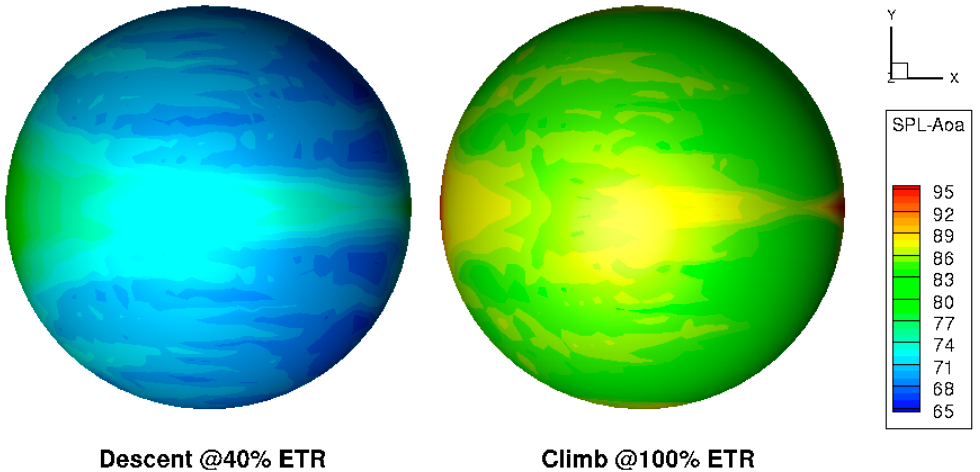
Figure 22. Motorization 2, OASPL-A, in decibels, on the sphere, top view, in the two flight conditions analysed.